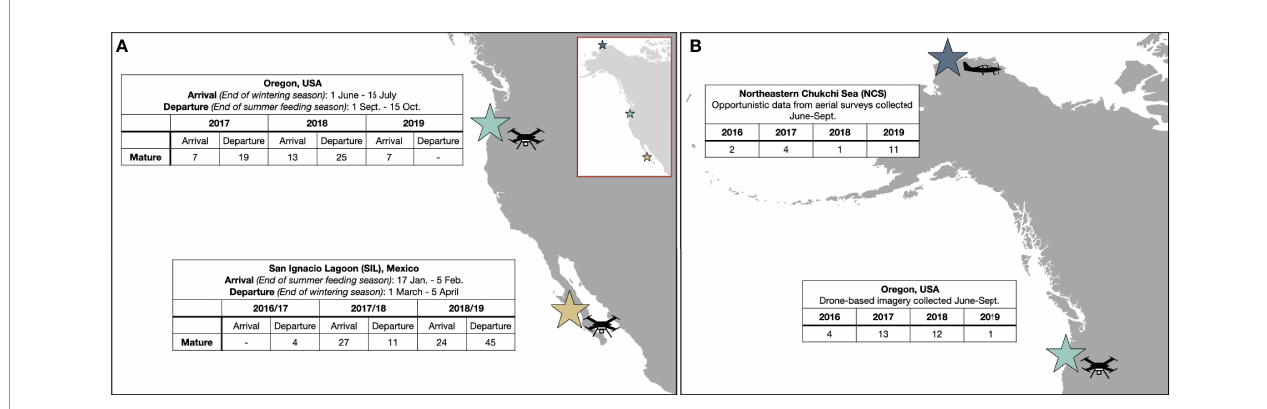
FIGURE 1 | Maps illustrating the sample sites, sample sizes, and time periods of the datasets. (A) Dataset used for the primary analysis based on drone-based data collected off of Oregon, USA and San Ignacio Lagoon, Baja California Sur, Mexico (SIL). The tables provide sample size of images analyzed per period and sub- group. (B) Opportunistic dataset of images collected during aerial surveys in the Arctic (Northeastern Chukchi Sea; NCS) and a subset of drone-based images collected during the same years and months off the Oregon coast, USA. The inset in (A) illustrates the locations of all three